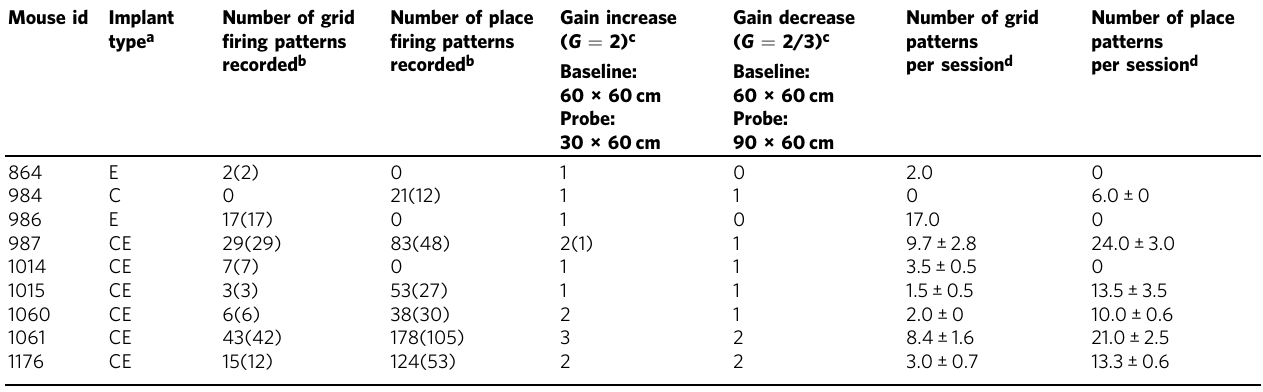
‘ random foraging ’ task, during which visible beacons were placed in the square box at random locations (at any given time only one beacon was visible), and a ‘ fading beacon ’ task, during which animals had to learn to navigate to a fi xed location for invisible rewards (see ref. 21 for details). Manipulating the gain of visual motion vs physical motion . After the animals had been trained in the ‘ fading beacon ’ task, they ran in a 60 ×60 cm VR square (Supplementary Figure 13) as their baseline environment. A probe session con- sisted of a 40-min random-foraging baseline trial followed by a 40-min random- foraging probe trial and a fi nal 20-min real-world (R) trial. In the probe trial, the ball-movement to visual-movement gain setting on one of the axes was either double for the gain increase manipulation (gain 'G' = 2; i.e. animals had to run half of the distance on the ball to move the same distance in the visual VR on the manipulated axis compared to the baseline trial) or 2/3 for the gain decrease manipulation (gain 'G' = 2; i.e. animals had to run 1.5× the distance on the ball to cover the same distance in the visual VR on the manipulated axis compared to the baseline trial). The location in virtual environments can be plotted in motor coordinates or visual coordinates. In baseline trials (where Gain = 1) these locations and the size of the virtual environment is the same in both coordinates. In probe trials, where the ball-to-vision gain changed (Gain = 2 or 2/3), environment size is different to the 60× 60cm baseline when measured in motor coordinates (i.e. 30 × 60cm or 90× 60 cm) but is the same in visual coordinates. We did not use Gain = 1/2 probe trials, as large environments — 120 cm or more across in motor coordinates — become impractical in terms of getting good coverage and also produce less stable grid cell fi ring patterns near to the centre, presumably re fl ecting the absence of local cues and large distance and low parallax of visual cues to location. Data analysis . Spike sorting was performed of fl ine using an automated clustering algorithm (KlustaKwik) followed by a manual review and editing step using an interactive graphical tool (waveform, Daniel Manson, http://d1manson.github.io/ waveform/). After spike sorting, fi ring rate maps were constructed by binning animals ’ positions into 1.5× 1.5cm bins, assigning spikes to each bin, smoothing both position maps and spike maps separately using a 5× 5 boxcar fi lter, and fi nally dividing the smoothed spike maps by the smoothed position maps. In VR probe trials, relative virtual/visual positions were different from relative physical positions on the ball due to the changing gain between visual movement and physical movement. Rate maps in a visual coordinate were constructed by binning animal ’ s virtual (visual) locations. Then rate maps in a motor coordinate were reconstructed by linear interpolation of the existing rate maps according to the applying gain ratio. Cells were classi fi ed as place cells if their spatial information in the baseline trial exceeded the 99th percentile of a 1000 shuf fl ed distribution of spatial information scores calculated from rate maps where spike times were randomly offset relative to position by at least 4s. Cells were classi fi ed as grid cells if their gridness scores in the baseline trial exceeded the 99th percentile of a shuf fl ed distribution of 1000 gridness scores, following refs. 27,41 . For each shuf fl e, a fi xed time offset was added to all spike times for each cell, with spike times after the end of the trial ‘ wrapped ’ to the beginning of the trial. Position data was unchanged. In this way, the temporal dynamics of the spike train were preserved, but the relation of the spikes to position was uncoupled. Each cell was compared to its own individual shuf fl ed data. To check that grid-like responses were not generated by visual input from the NATURE COMMUNICATIONS| (2019) 10:630